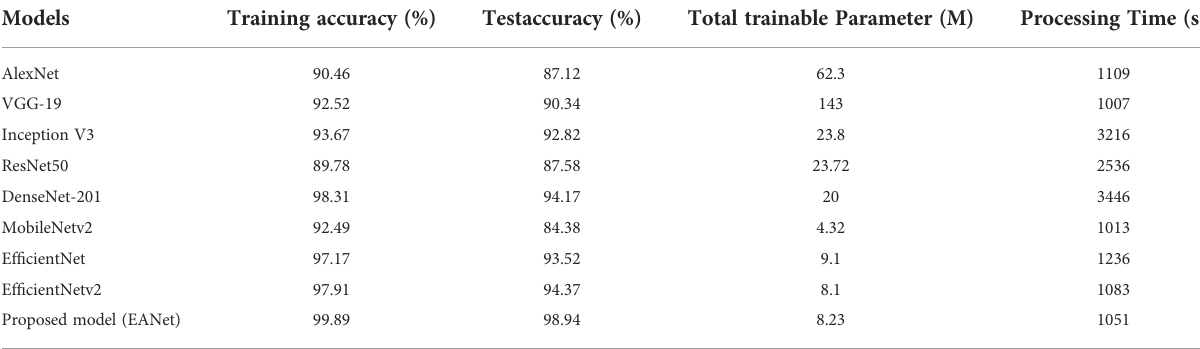
TABLE 5 Comparative results of the proposed technique with other DL models.